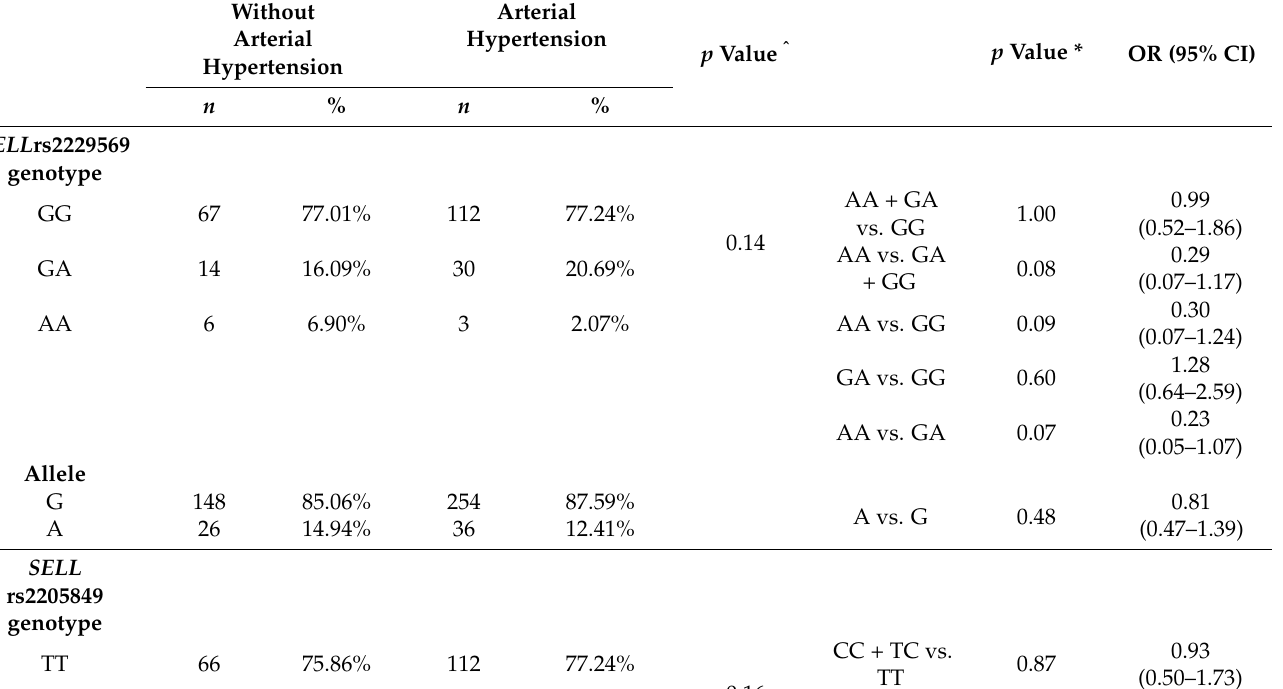
Table 6. Distributions of the SELL rs2229569, rs2205849 and GUCY1A1 rs7692387 genotypes and alleles in UA patients with and without arterial hypertension